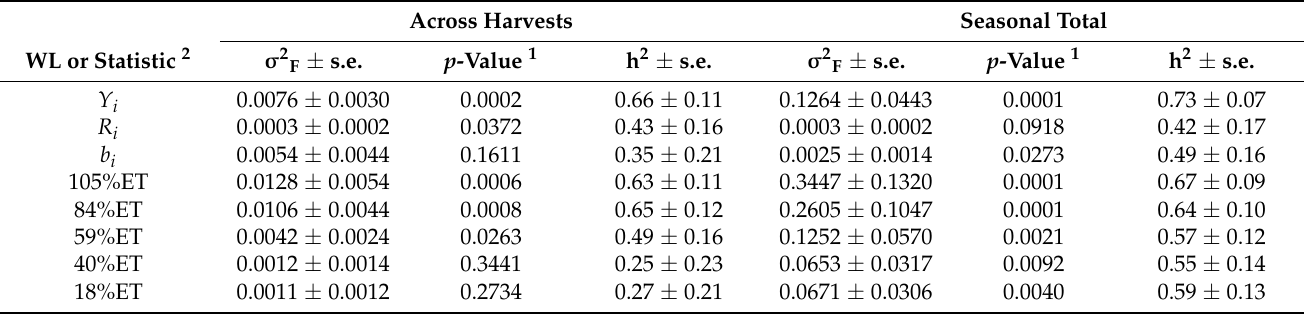
Table 3. Estimates of half-sib family variance ( σ 2 F ) and narrow sense heritability (h 2 ) of forage mass in a tall fescue breeding population based upon five harvests per season or the seasonal total. Estimates based upon family mean performance of 28 families evaluated in a line-source irrigation experiment with 5 water levels (WL) from 2001 to 2003 near Logan, UT, USA.